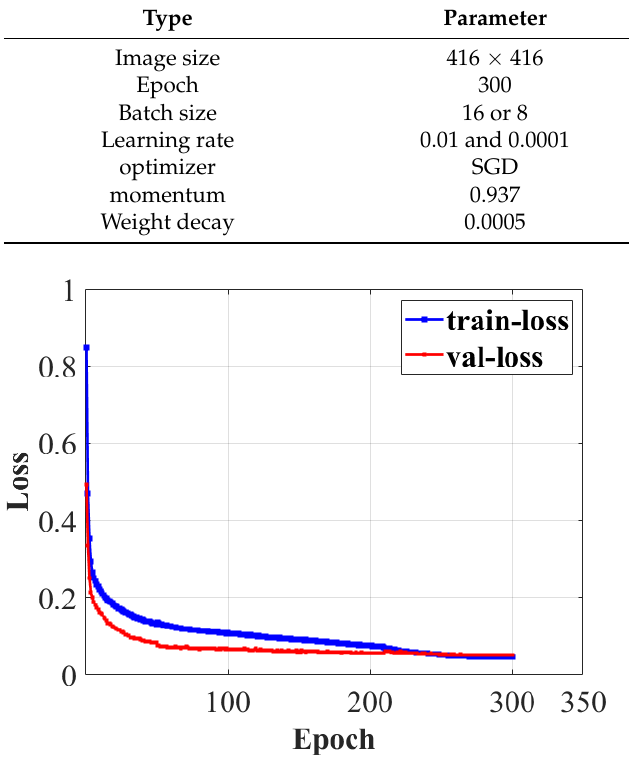
Figure 8. The loss value of YOLOv4-MCA on